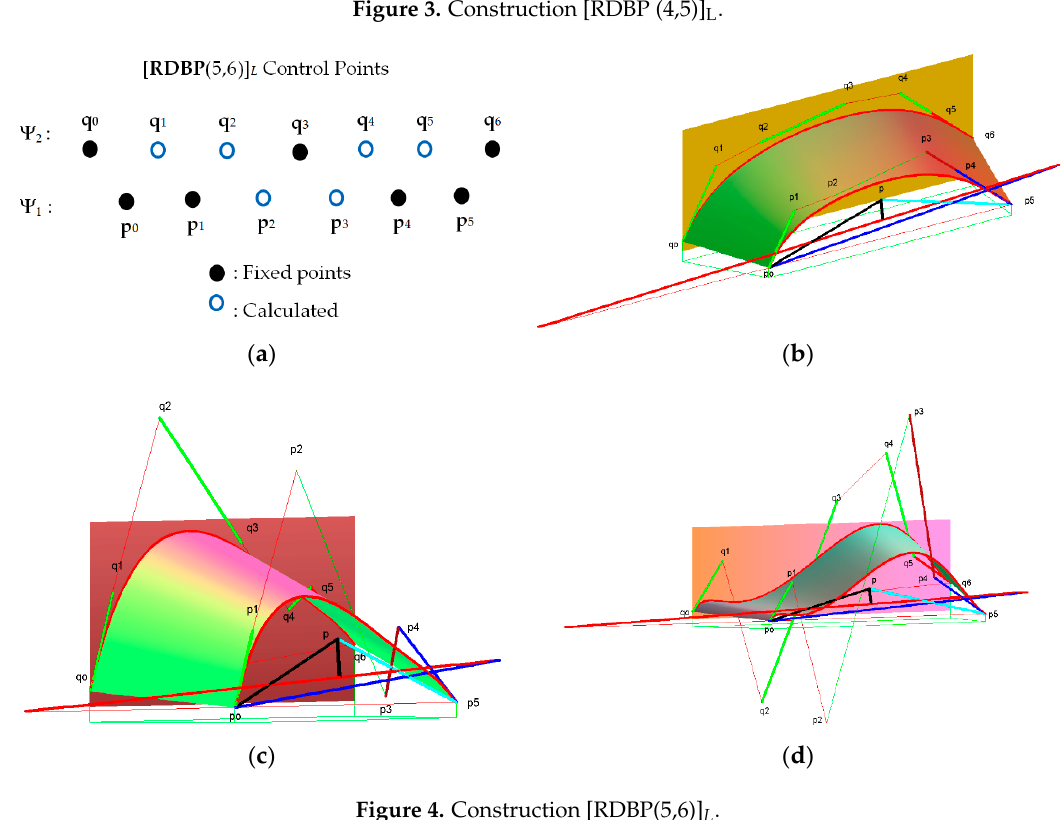
Figure 4. Construction [RDBP(5,6)] L .